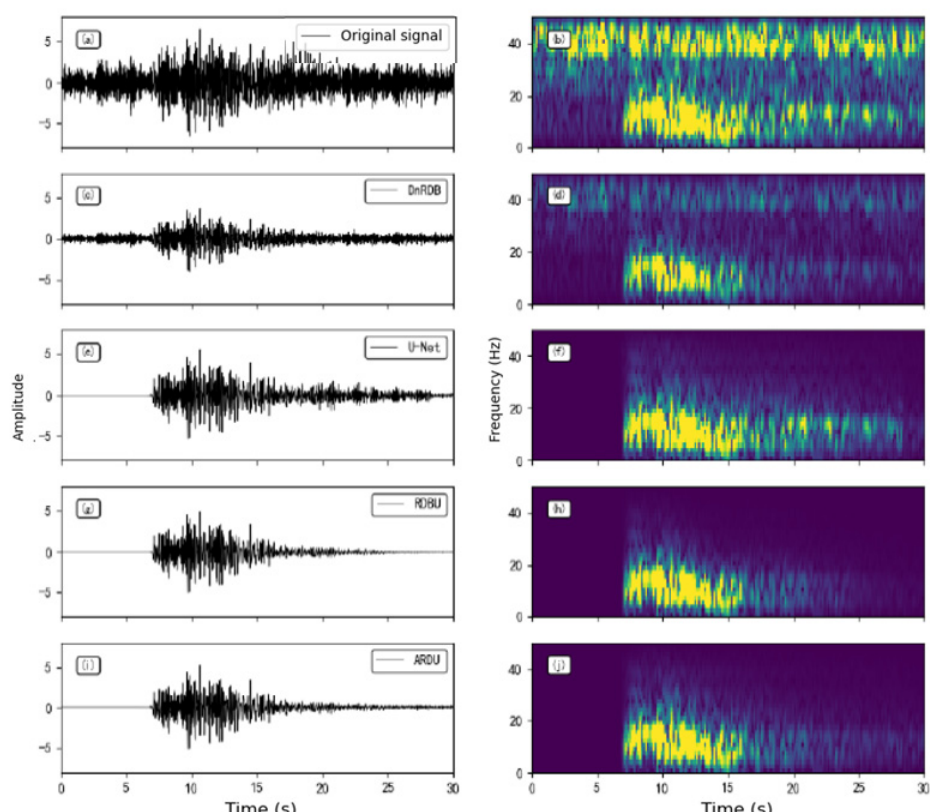
Figure 15. Denoising results of actual seismic signals by different denoising methods.